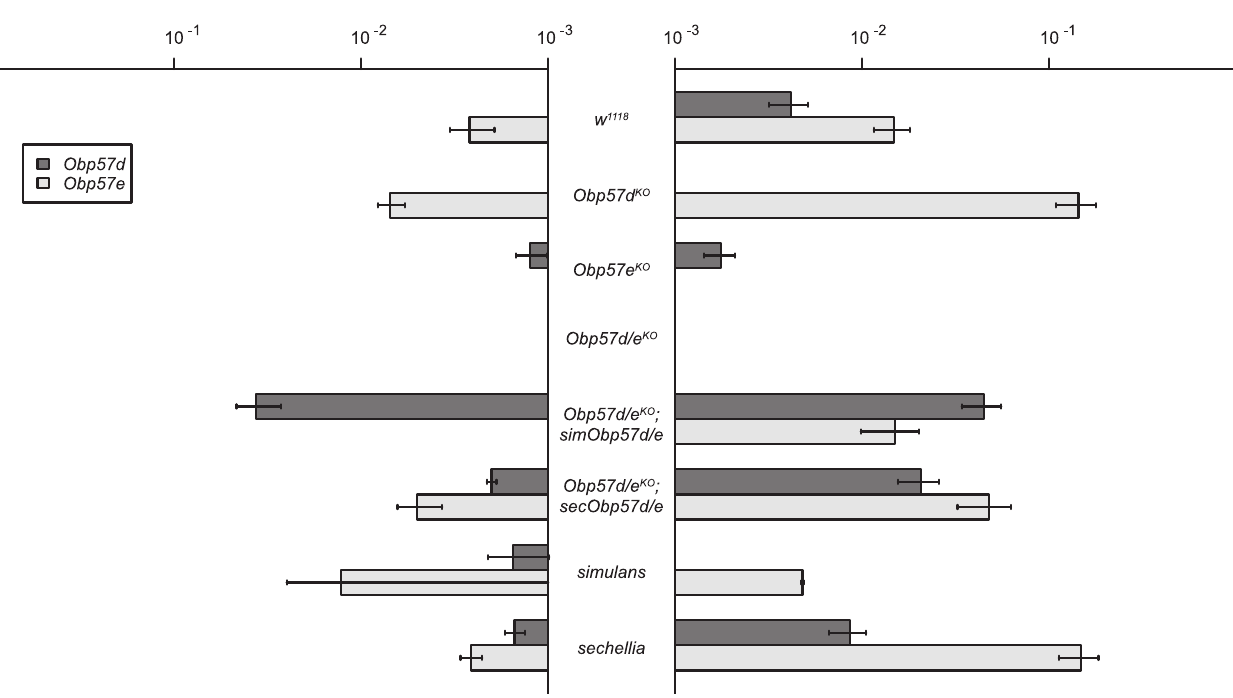
Figure 2. Quantitative RT-PCR Analysis of Obp57d and Obp57e Transcripts Heads and legs from 20 staged females were used for analysis. Transcript level relative to that of the ribosomal protein gene rp49 is shown. Each bar represents the mean of three replicates. Error bars indicate standard error.